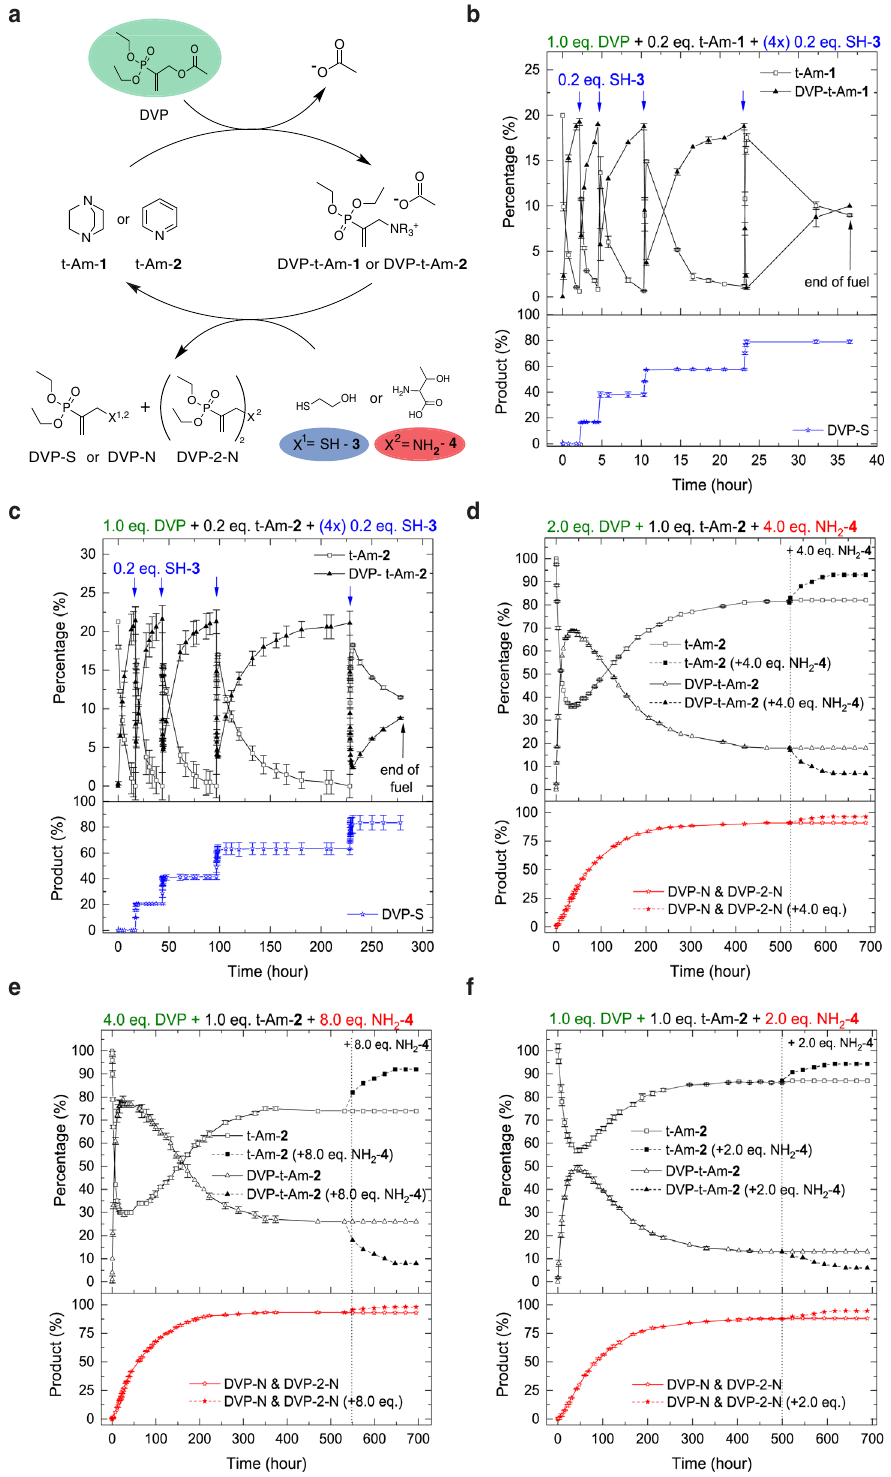
Fig. 2 | Small molecule CRN model for signal-induced and fuel-driven auton- omous cycle. a CRNof fuel with t-Am- 1 (DABCO) or t-Am- 2 (pyridine) and SH- 3 in signal-induced mode or fuel with t-Am- 2 and excess NH 2 - 4 in fuel-driven autono- mous mode. Conversion of the reactants was monitored by 1 H NMR over time in D 2 O/phosphate buffer 1:9 (pH=7.4, 0.1M (signal-induced cycle) or 0.5M (auton- omouscycle))atroomtemperature. b Signal-inducedcycle(SupplementaryFig.6) with t-Am- 1 : DVP (42mM, 1.0 eq.),t-Am- 1 (0.2 eq.) and four times addition of SH- 3 (0.2 eq.). c Signal induced cycle (Supplementary Fig. 7) with t-Am- 2 : DVP